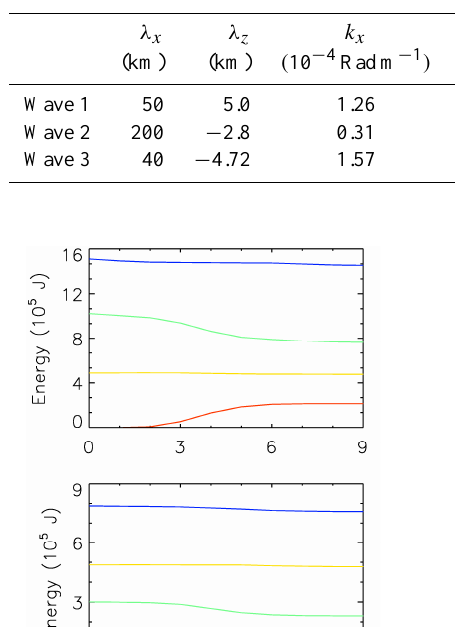
Table 2. Initial parameters of waves 1–3 regarded as initial perturbations in cases 4–6.